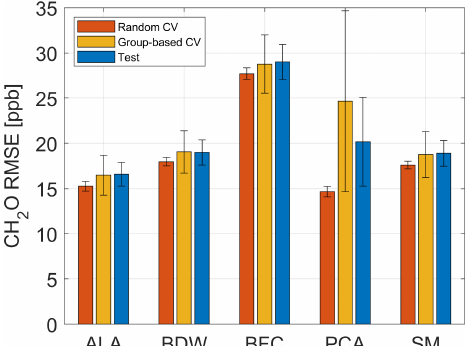
Figure 6. Random CV, group-based CV, and test RMSE of the five FE algorithms using Pearson as FS and PLSR with n comp = 20 for 100 trials with different randomized UGM splits and the formalde- hyde concentration as target. ALA is the adaptive linear approxima- tion, BDW is the best Daubechies wavelets, BFC is the best Fourier coefficients, PCA is the principal component analysis, and SM is the statistical moments.